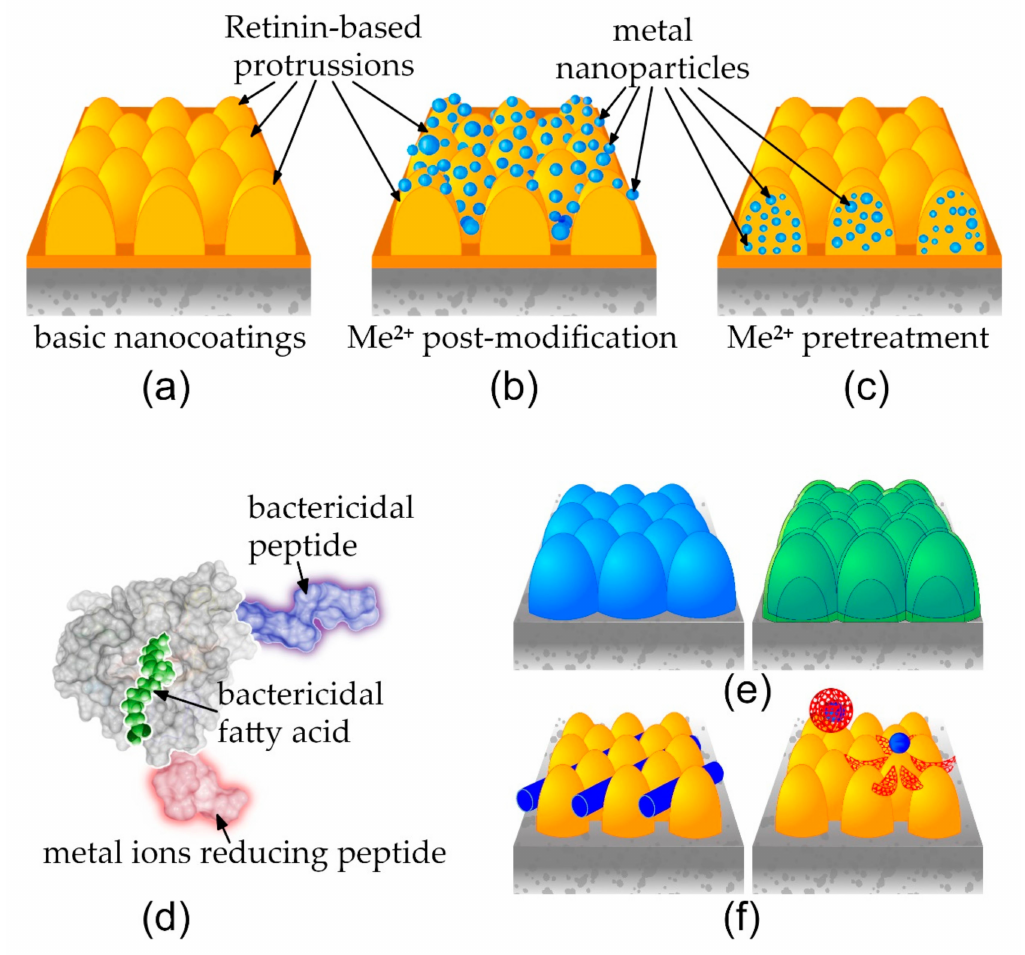
Figure 1. Functionalization of bionic nanocoatings. Retinin-based nanocoatings ( a ) can be metalized, by coalescence of metal nanoparticles after the nanocoating formation ( b ) or by bioconjugation before the process of nanocoating self-assembly ( c ). Possible functionalizations include modifications of the core protein and fatty acid components, to build nanocoatings with enhanced anti-infective properties ( d ). Further, single- or multi-layering with metals or other compounds can be envisioned ( e ), along with integration of various nanoscale objects, such as carbon nanotubes or complex multi-compound nanoparticles ( f ), for diverse applications from medicine to